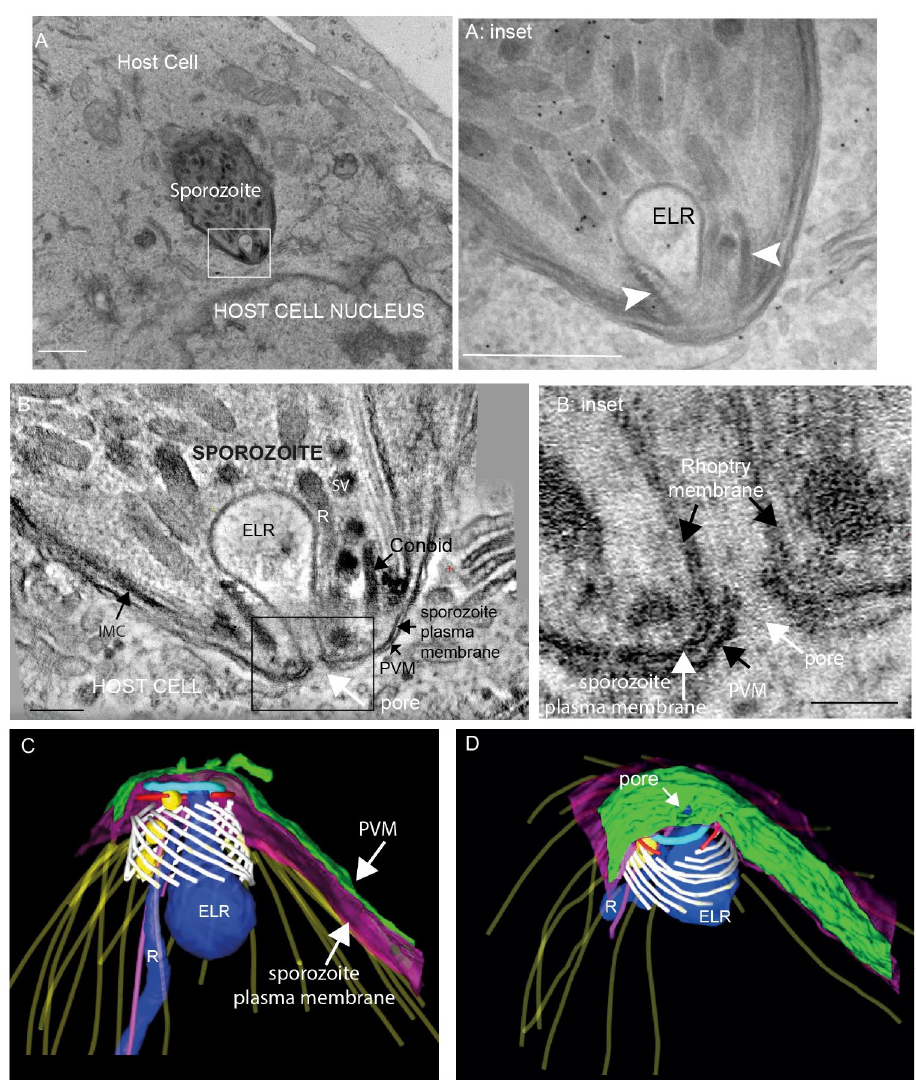
Fig 3. Characterisation of an electron lucent rhoptry in an intracellular or invading sporozoite. A: Slice from a Transmission electron microscopy image illustrating an invading or intracellular sporozoite with an electron lucent rhoptry (ELR) (box and A: inset) close to a host cell nucleus (30 min post-infection sample) scale bar 1 μ m; A: inset: Higher magnification of A illustrating the ELR within the conoid (white arrowheads). Scale bar 500nm; B and B: inset: Slice from a tomogram showing the electron lucent ‘empty’ rhoptry (ELR) which appeared to be continuous with the parasite plasma membrane and associated at its apex with a pore in the parasitophorous membrane creating a channel passing through both the parasite plasma membrane and the PVM connecting the ‘empty rhoptry’ directly with host cell cytoplasm. B–scale bar 100nm; B inset scale bar 50nm; C and D: Segmentation of a serial tomogram outlined in A and B to illustrate the three dimensional organisation and relative positioning of the electron lucent rhoptry (ELR– dark blue), electron dense rhoptry (R–dark blue), conoid fibres (white), MVs (yellow), parasite plasma membrane (purple), parasitophorous vacuole membrane (green), PCR-1 and 2 (light blue and red), subpellicular microtubules (yellow), intra-conoidal microtubules